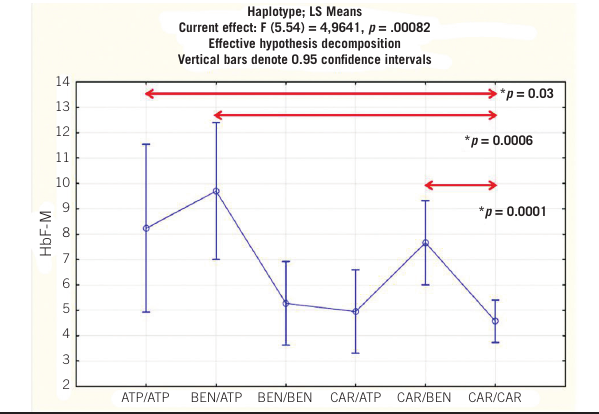
FigurE − Representation of average HbF level in